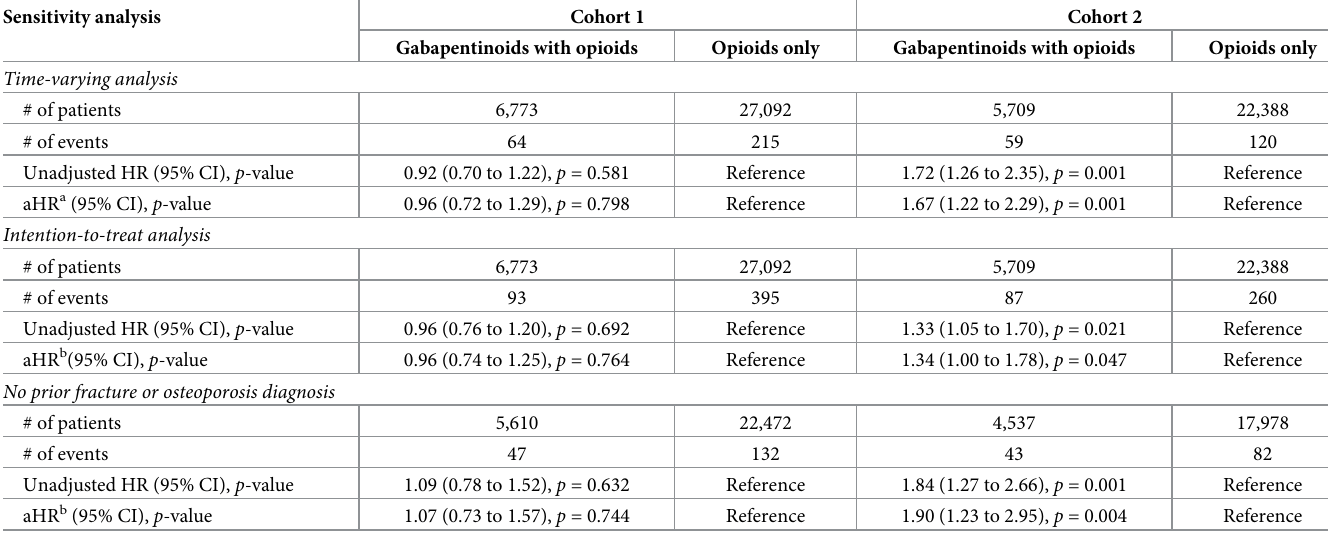
Table 3. Risk of fall-related injury comparing concurrent gabapentinoid–opioid users and opioid-only users in sensitivity analyses. Sensitivity